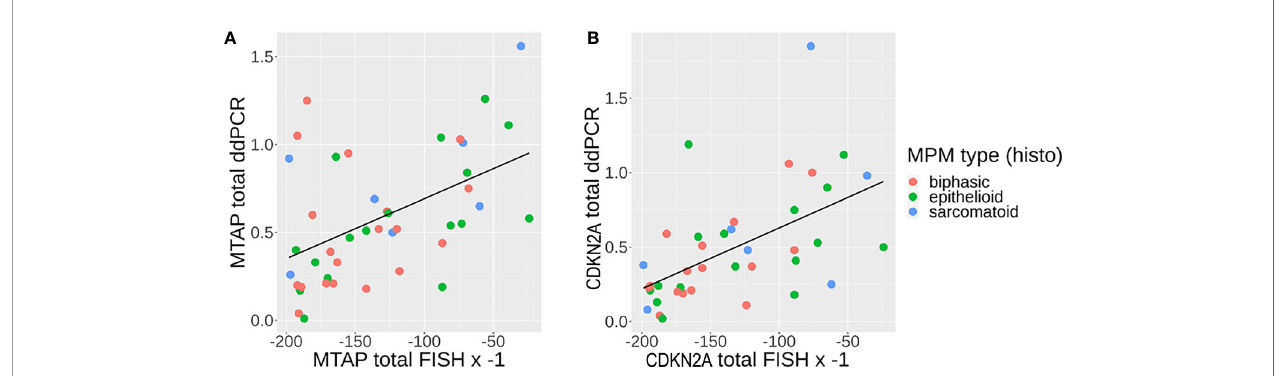
FIGURE 4 | (A, B) Correlation between fl uorescence in situ hybridization (FISH) (multiplied by − 1, since any one cell containing genomic loss will count as 1) and droplet digital PCR (ddPCR) results (genomic loss will show no detection) for (A) MTAP and (B) CDKN2A, with line of linear regression in black [A: methylthioadenosine phosphorylase (MTAP): slope = 0.003411, y-intercept = 1.034011, R 2 = 0.2404; B: CDKN2A: slope = 0.004099, y-intercept = 1.040047, R 2 = 0.302].